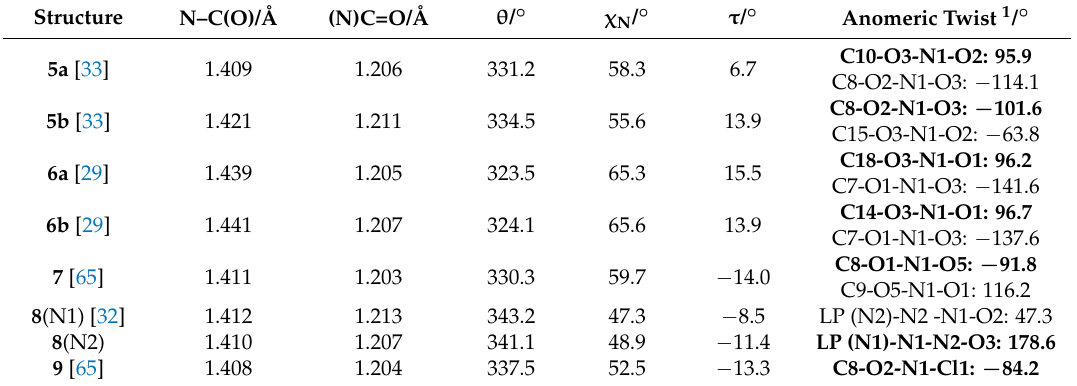
Table 1. Selected structural data for anomeric amides 5 – 9 from X-ray structures (Figure 6).